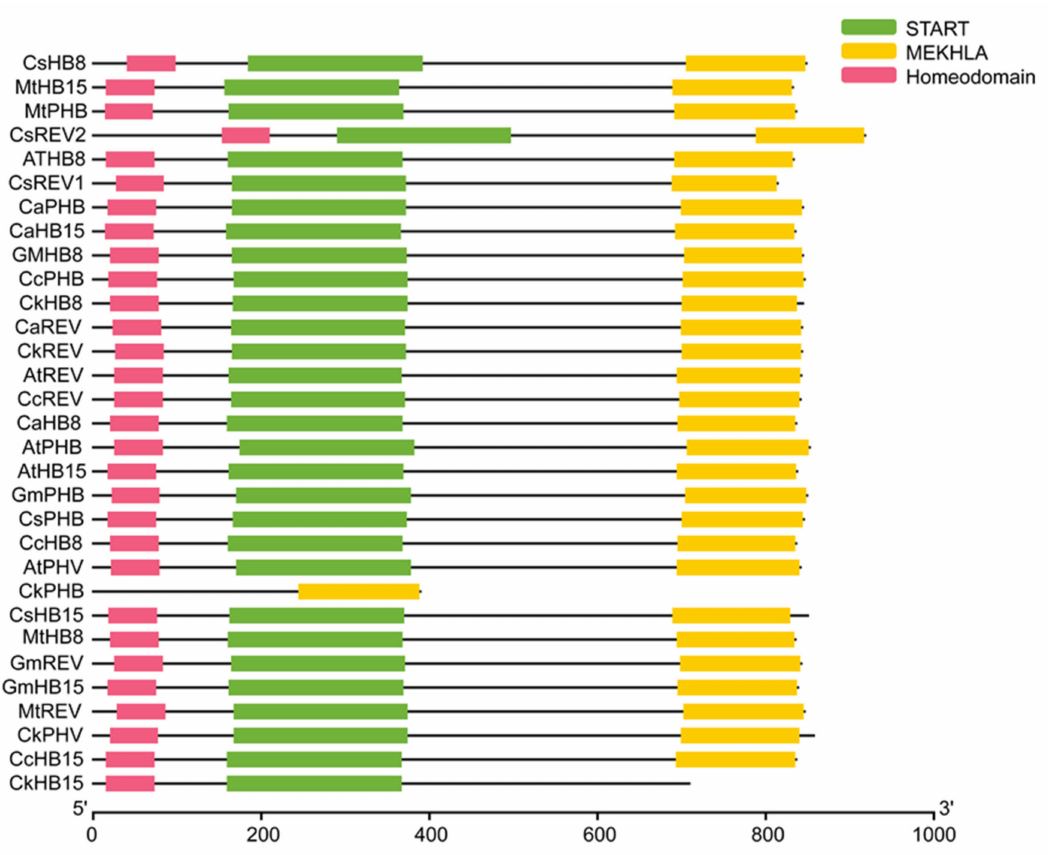
Figure 2. Conserved domain analysis of HD-ZIP III family between C. korshinskii , G. max , C. arietinum , M. truncatula , C. cajan , C. sinensis , and A. thaliana .